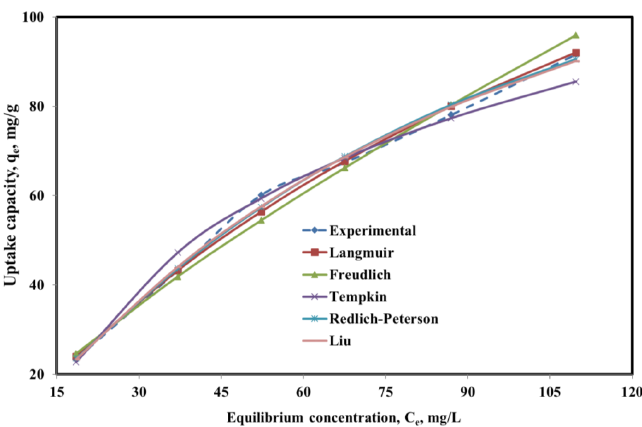
Figure 5. Plots for experimental data vs. predictions for non-linear kinetic models for SBAC-MgAlFe phenol uptake.